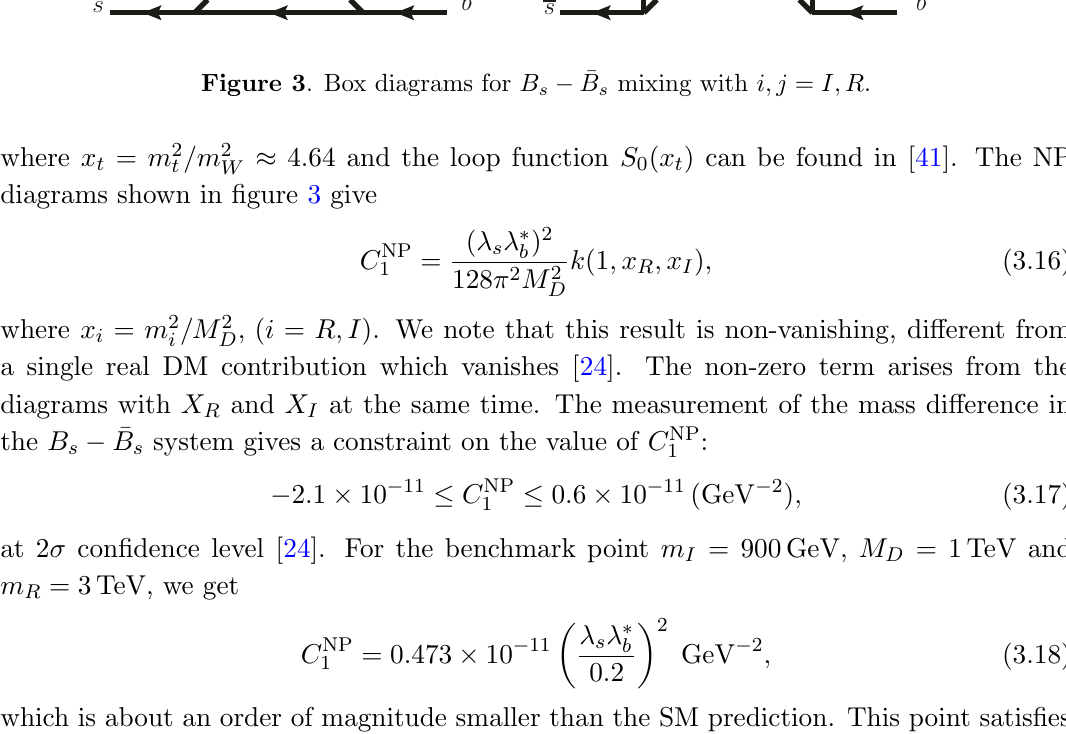
Figure 3 . Box diagrams for B s